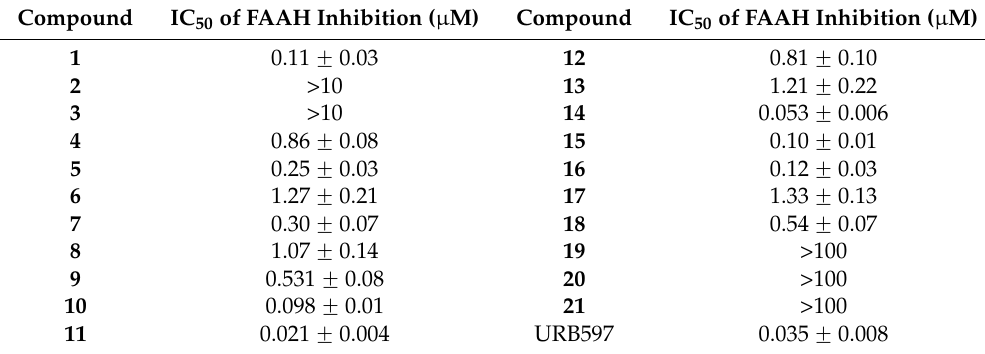
Table 1. FAAH inhibitory activity of compounds 1 – 21 and URB597.